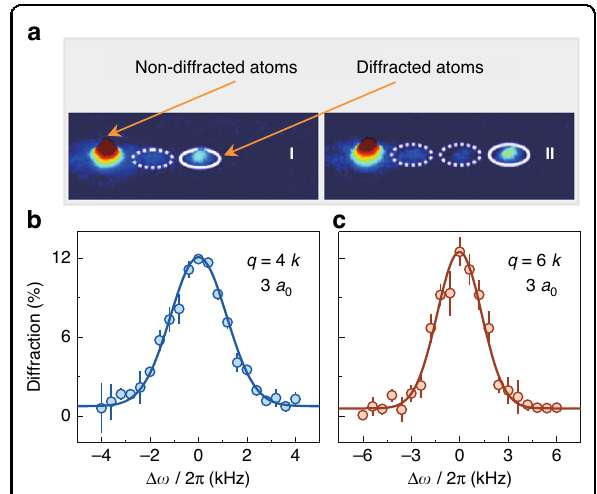
Fig. 3 High-order Bragg spectra. a Second- and third-order Bragg diffractions correspond to the stimulated four- (I) and six-photon (II) processes with the momentum transfers ħ q = 4 ħ k and 6 ħ k , respectively. Typical absorption images are taken after the 1 ms Bragg pulse and 22 ms time-of- fl ight, and about 10% atoms are coupled to the high-momentum states. b , c Diffracted faction of atoms as a function of frequency shift Δ ω normalized to the frequency difference ħ q 2 / (2 m ) in the noninteracting limit. The resonance shift is determined by a Gaussian fi t to the data (solid lines). Error bars denote the standard errors. In all panels, the scattering length is fi xed at a = 3 a 0